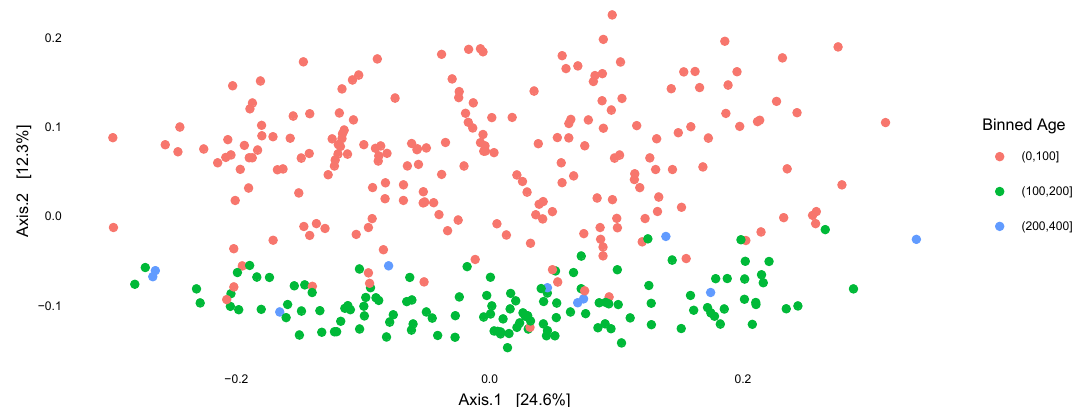
Figure 10. A PCoA plot using Bray-Curtis distance between